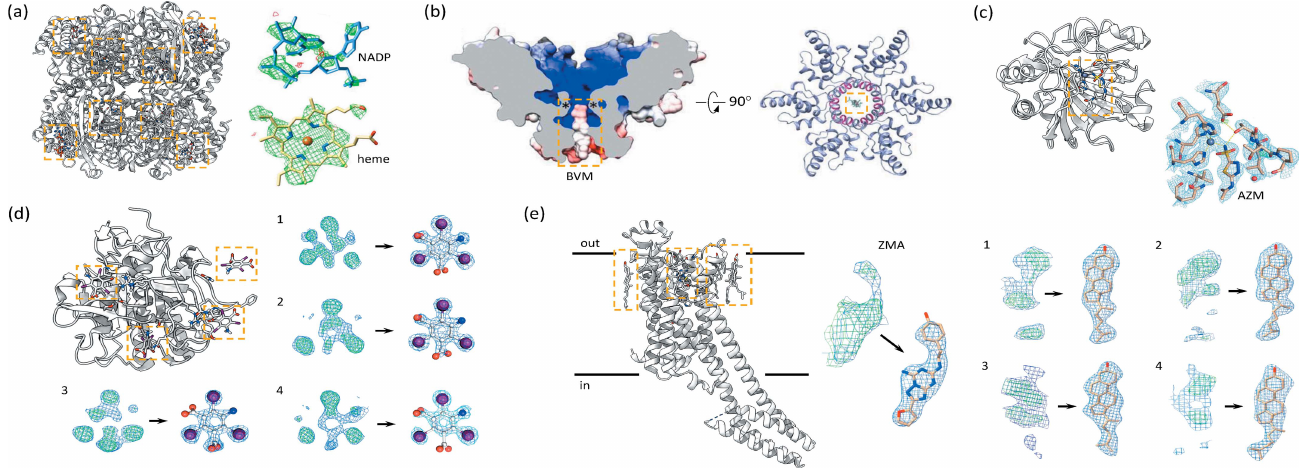
Figure 5 MicroED and drug discovery. ( a ) Ligand binding showing the heme group and NADP resolved by MicroED for bovine liver catalase (Nannenga, Shi, Hattne et al. , 2014). ( b ) Drug binding of the inhibitor bevirimat (BVM) in complex with the C-terminal domain of the HIV Gag protein fragment (Purdy et al. , 2018). ( c ) Drug-bound MicroED structure of human carbonic anhydrase isoform II (HCA II) complexed with the clinical drug acetazolamide (AZM) (Clabbers et al. , 2020). Inset shows the active site where the ligand is coordinated to the active site zinc metal co-factor. ( d ) Efficient ligand soaking into microcrystals was demonstrated from lamellae of proteinase K that were briefly soaked on-grid with I3C compounds (Martynowycz & Gonen, 2021 a ). Four I3C molecules could be identified in the difference map, each difference map is shown next to the observed map of the fitted and refined ligands. ( e ) Structure of the adenosine A 2A -receptor determined from LCP crystals using MicroED (Martynowycz, Shiriaeva et al. , 2021). The ligand ZM241385 (ZMA) could be resolved in the orthosteric pocket, as well as four surrounding cholesterol molecules bound to the receptor on the extracellular side. Difference maps are shown next to the refined maps with the fitted ligand and the four numbered cholesterol molecules. In all panels, the positions of the ligand in the protein models are highlighted with yellow rectangular